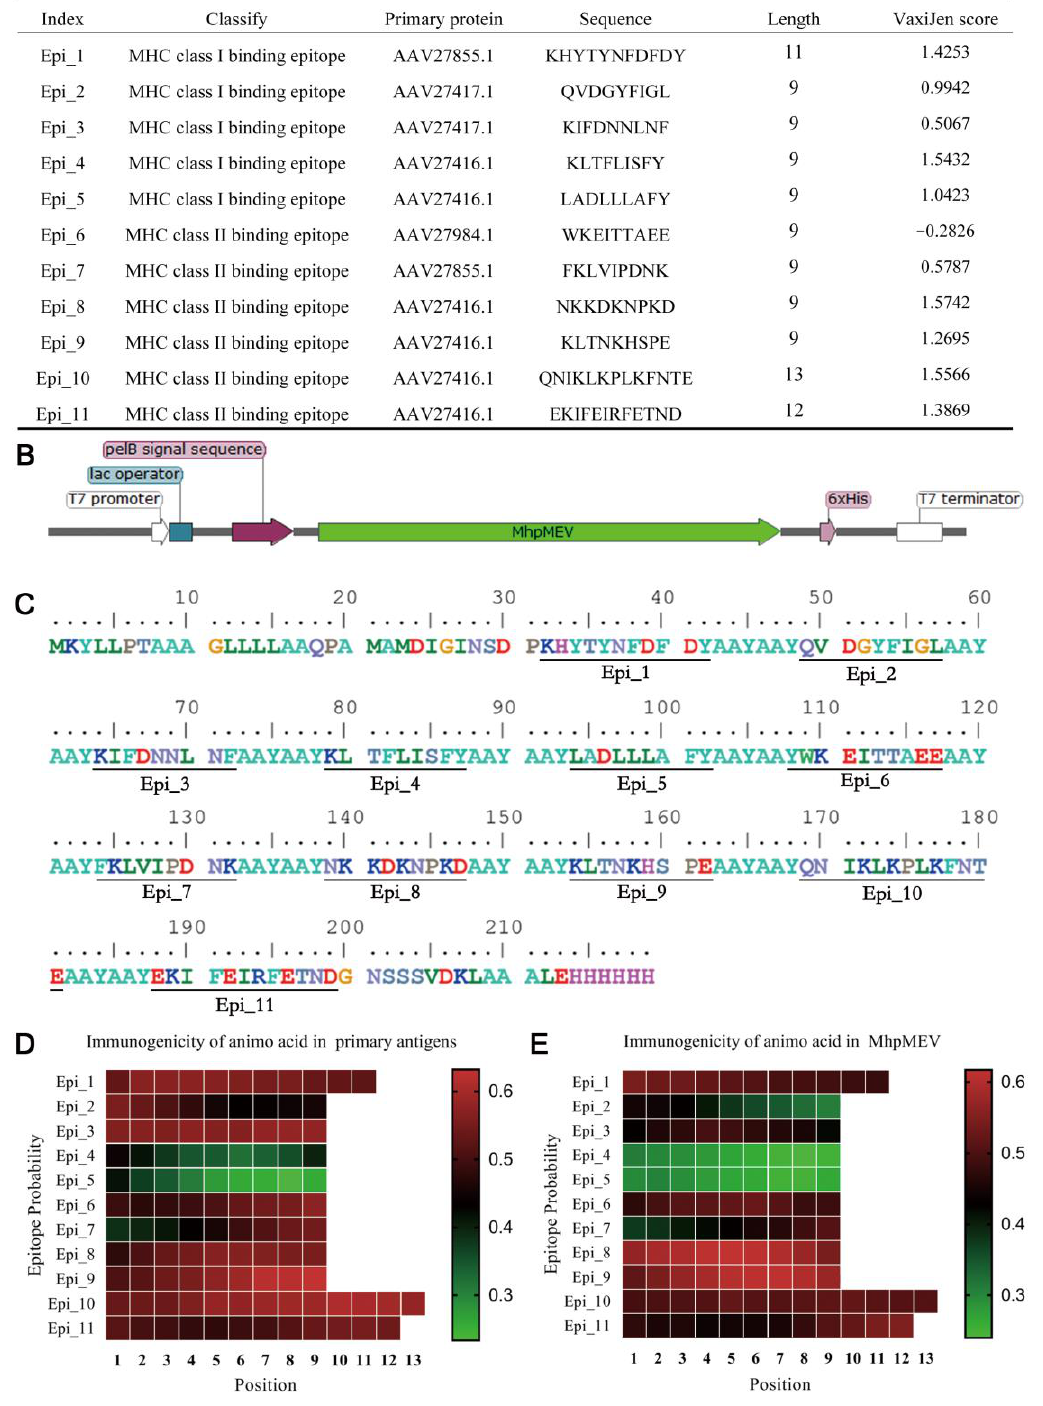
Figure 3. The design of the multi-epitope vaccine. ( A ) Identified MHC-I/II binding epitopes and their immunogenicity calculated by VaxiJen V2.0. ( B ) The open reading frame features of the MhpMEV expression vector. ( C ) The protein sequence of MhpMEV and the different epitopes are underlined. The immunogenicity of each epitope amino acid calculated by BepiPred 2.0 in the immunodominant antigens and MhpMEV is presented in ( D , E ), respectively.